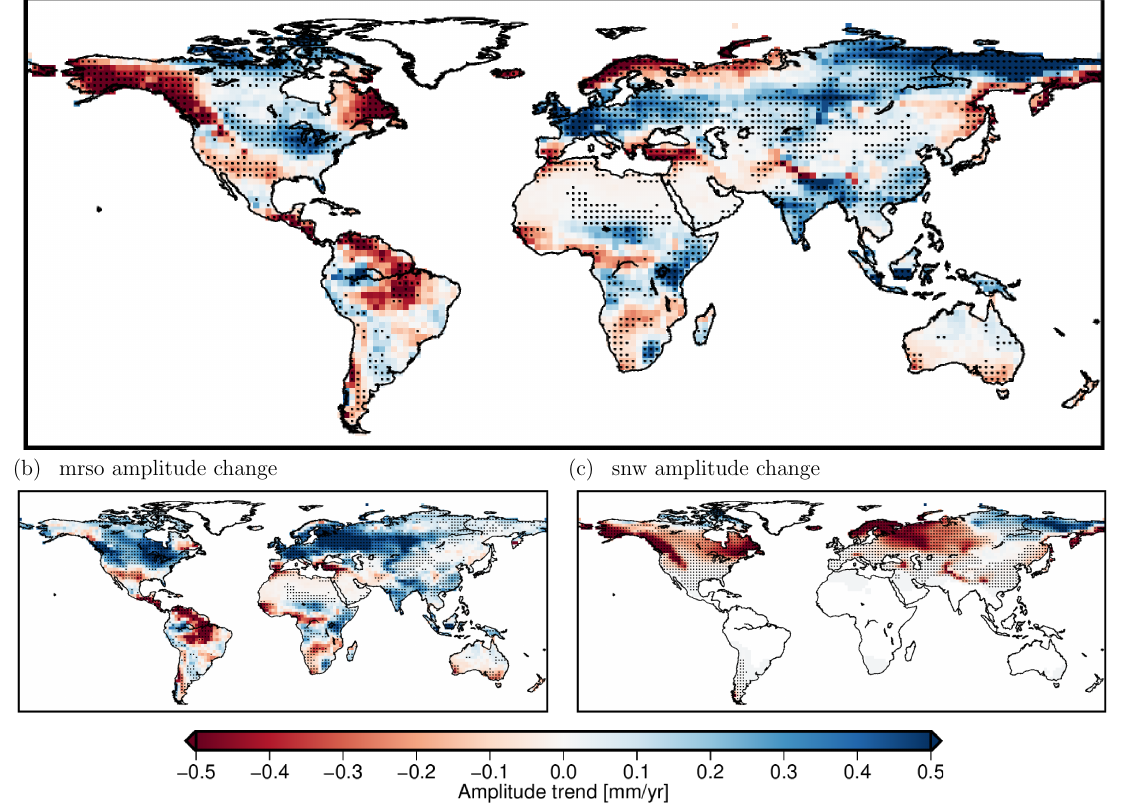
Figure 7. ( a ) MMMed mTWS annual amplitude change over 2000–2100. Stippling indicates regions where 13 or more of 17 models (i.e., ≥ 76%) agree on the sign of the amplitude change. ( b , c ) same as ( a ) but for mrso and